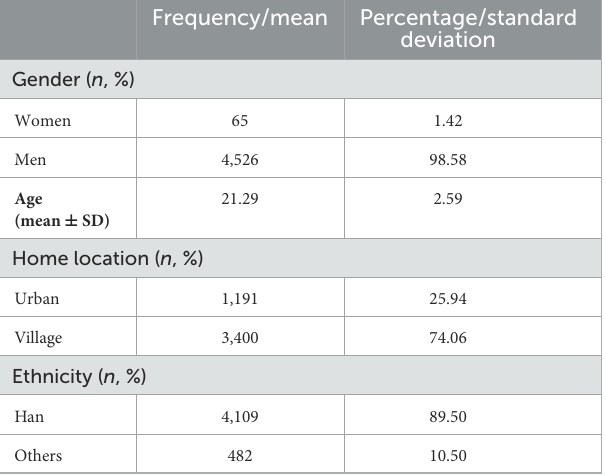
TABLE 1 Demographic information of 4,591 participants ( n = 4,591). TABLE 2 Demographic information of individuals who participated in the semi-structured interviews ( n =